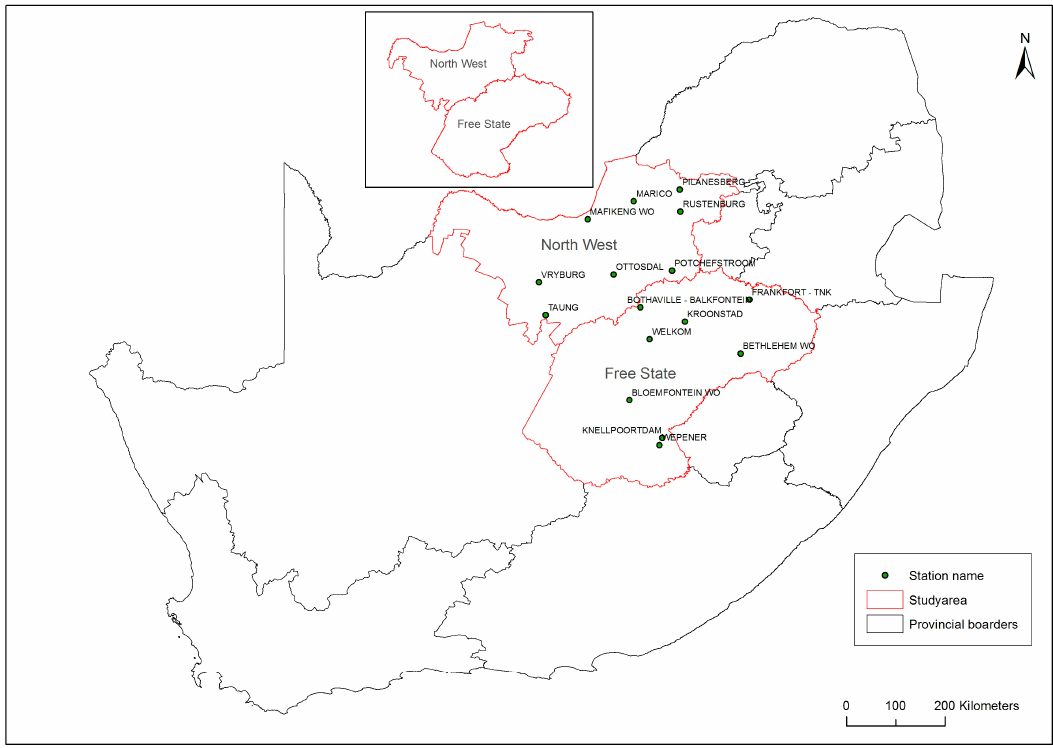
Figure 1. Distribution of weather stations within the North West and Free State Provinces.